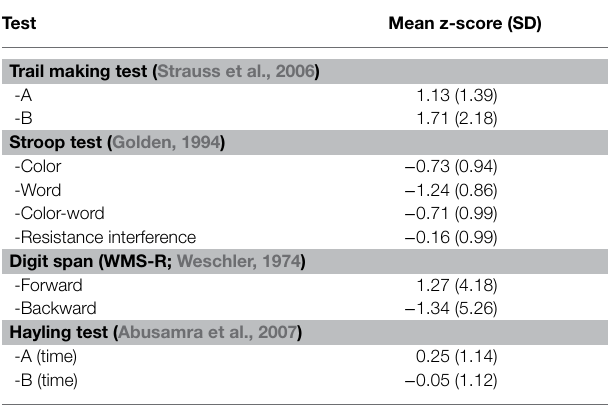
TABLE 1 | Scores cognitive